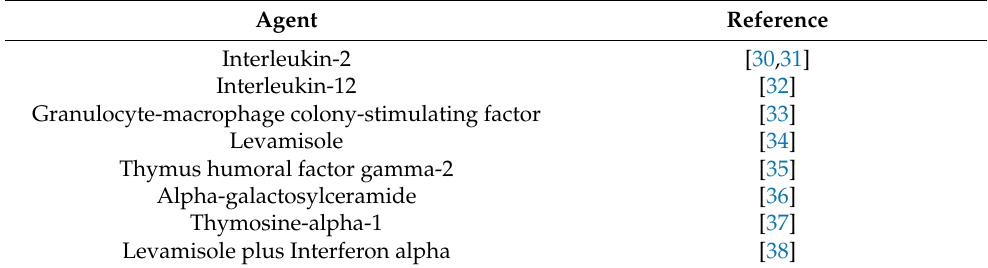
Table 2. Innovative immune therapy using polyclonal immune modulators.